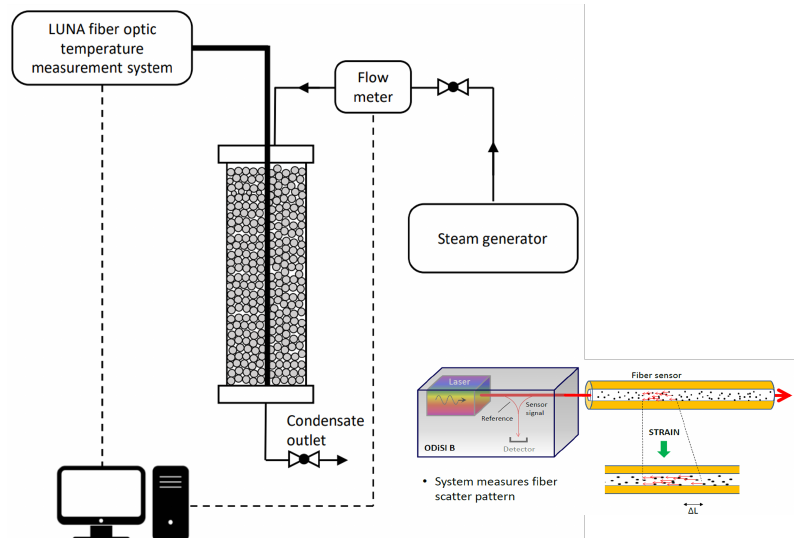
Figure 2. Schematic of an experimental steam setup of a packed bed heat sink consisting of a clear fused quartz tube, alumina particles, steel piping, a steam supply, and a fiber optic temperature sensing system.